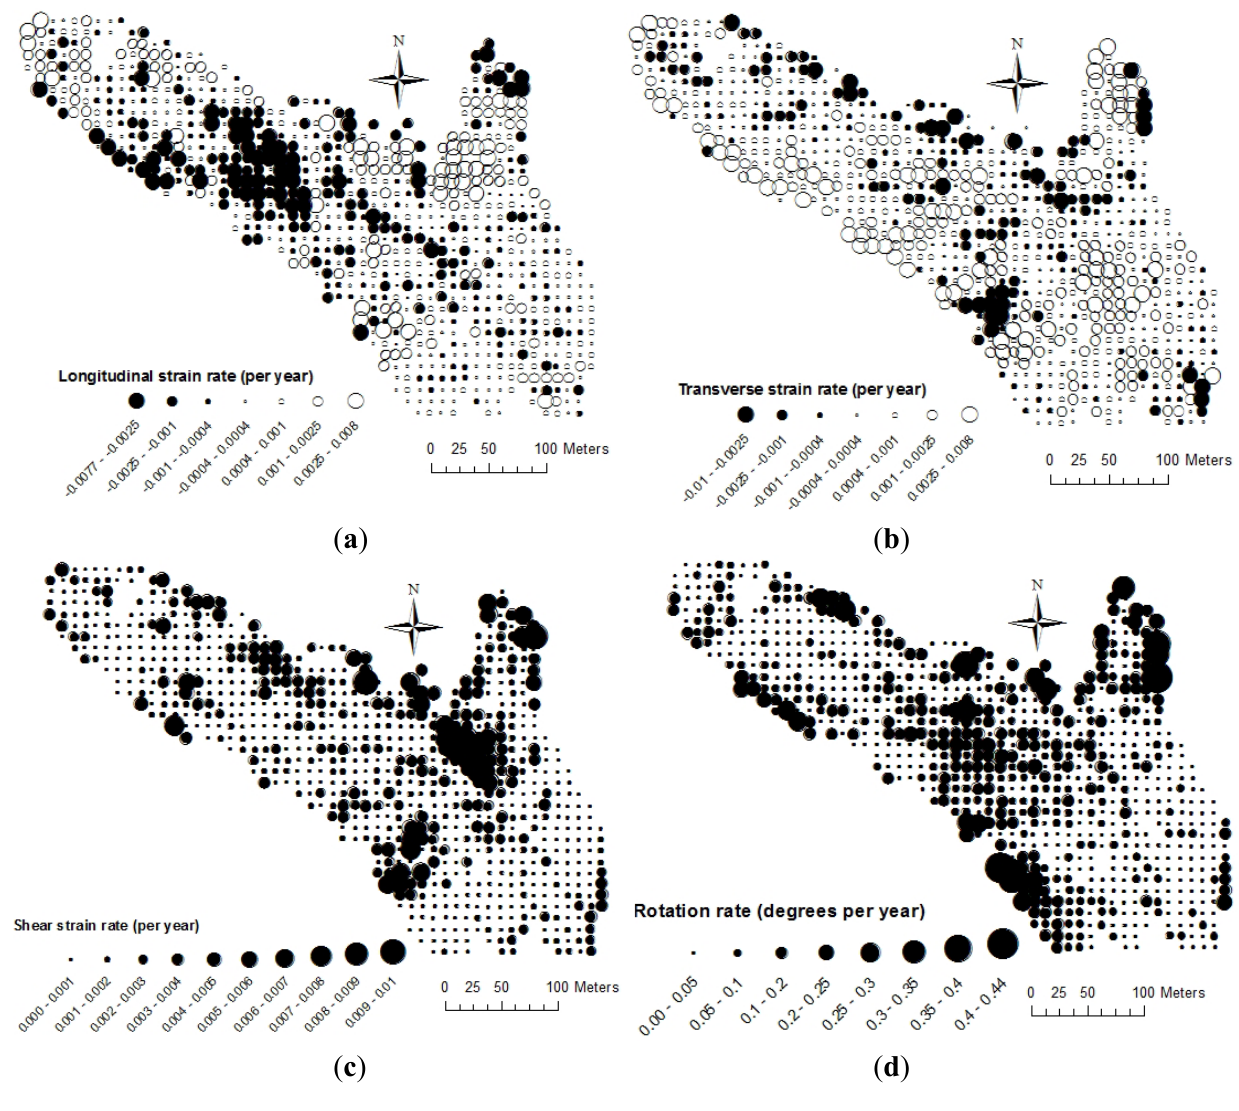
Figure 6. The longitudinal (cid:2013)(cid:4662) rotation rate φ(cid:4662) ( d ) for the Muragl